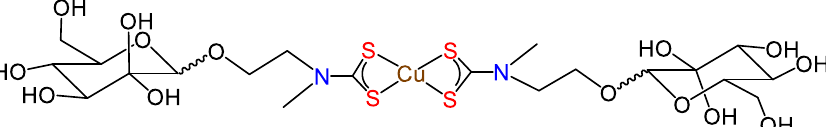
Figure 28. Line drawing of the molecular structure of a carbohydrate-functionalised dithiocarba- mate complex prepared by Fregona and co-workers. complex prepared by Fregona and